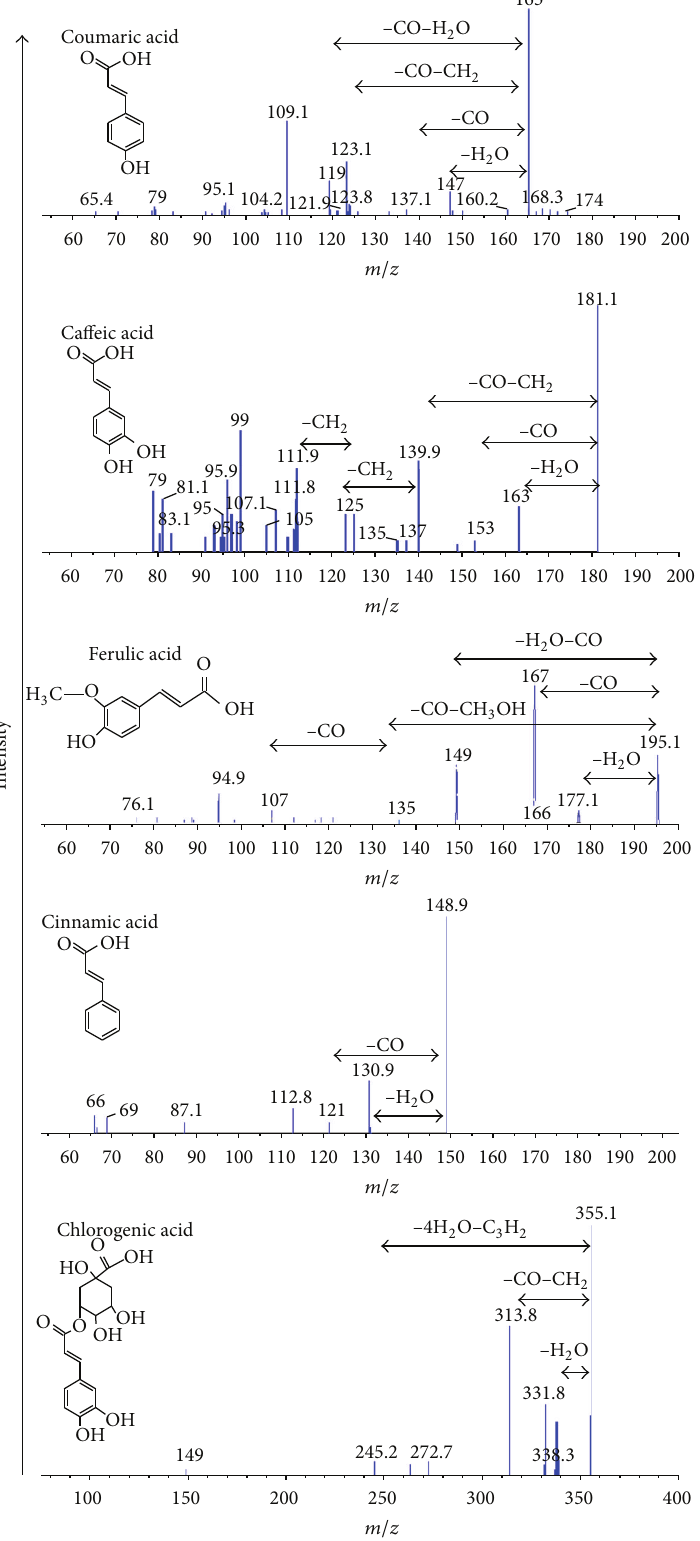
Figure 1: Mass spectra of phenolic acids at the positive mode of enhanced product ion